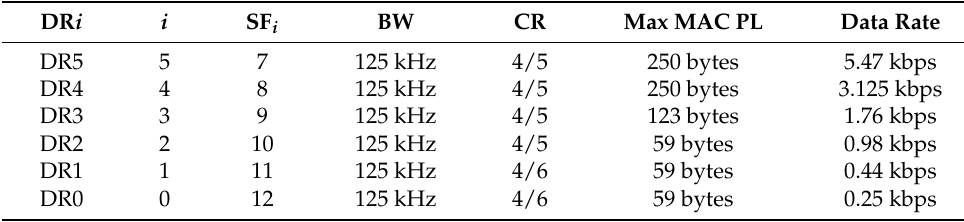
Table 2. LoRa DR mode characteristics in